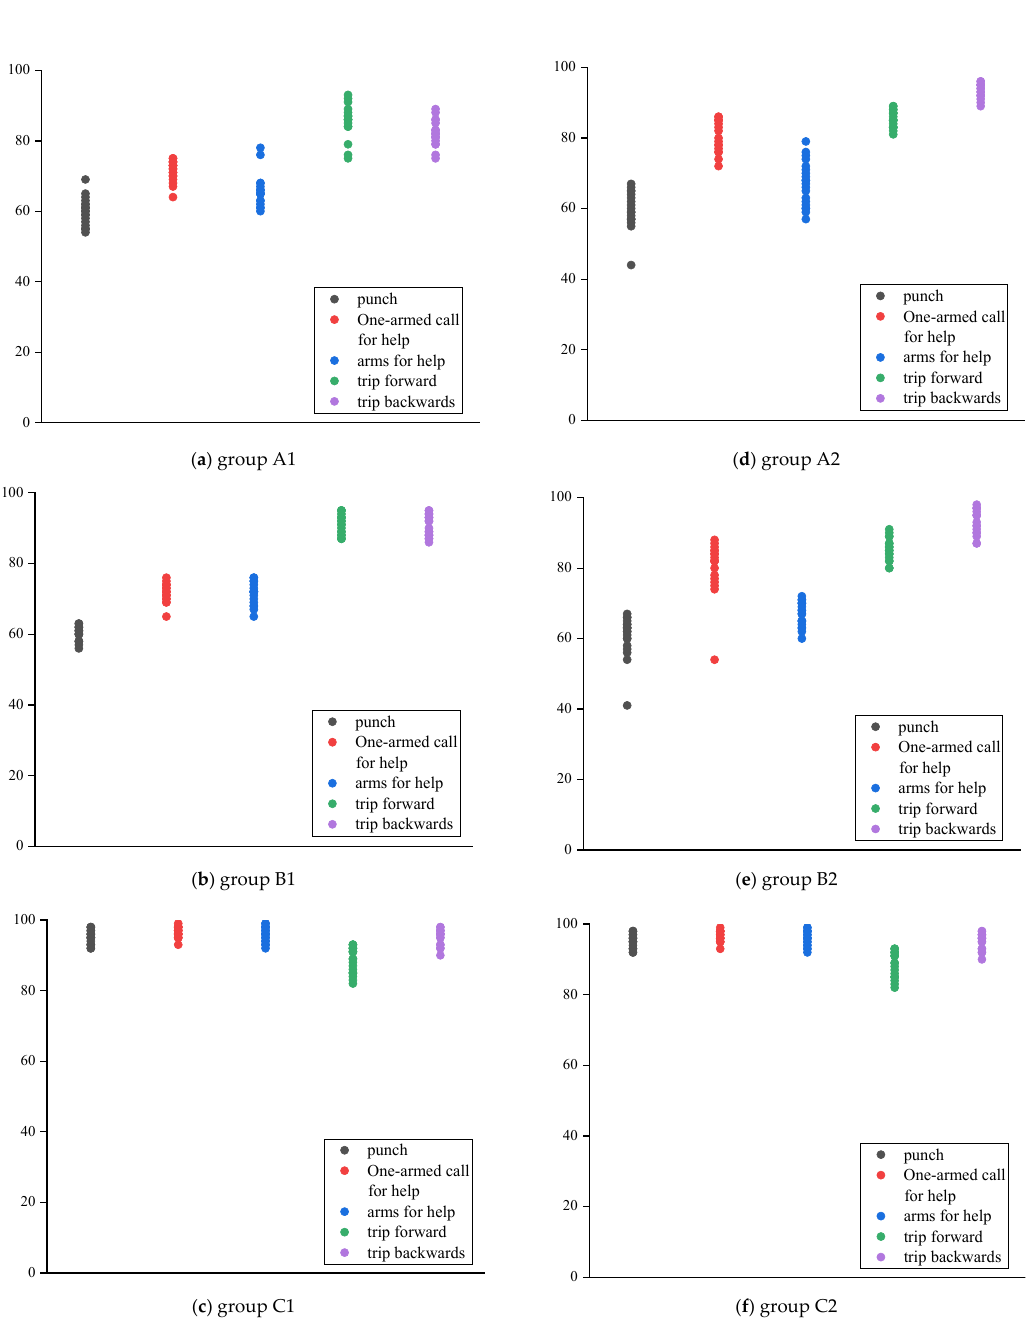
Figure 11. Result of overall joint selection. Table 7. Overall “adjacent joint method” identification results.